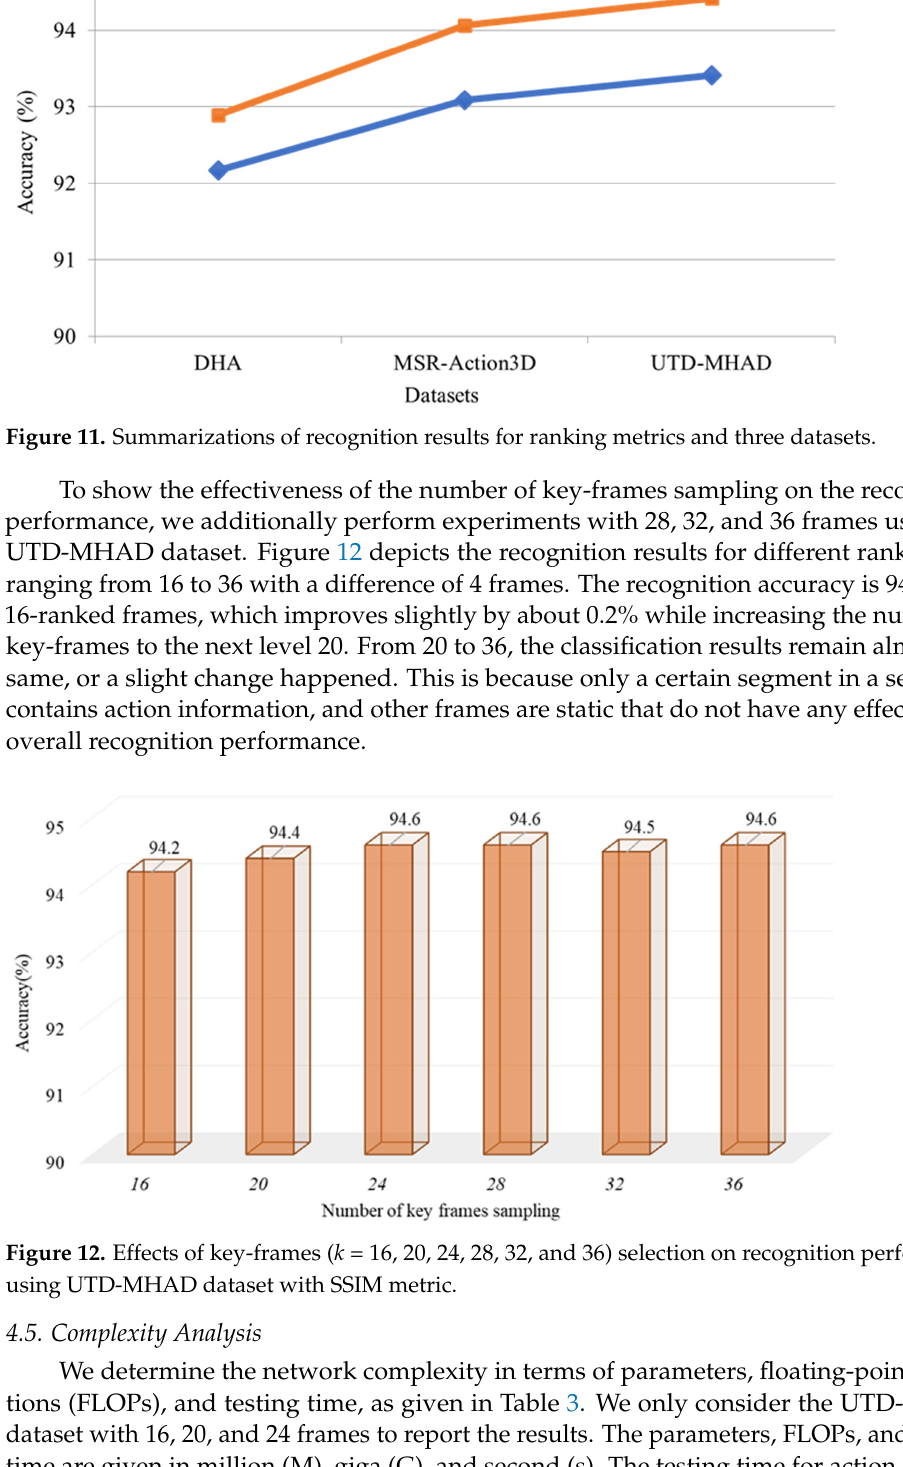
Table 3. Network complexity analysis.